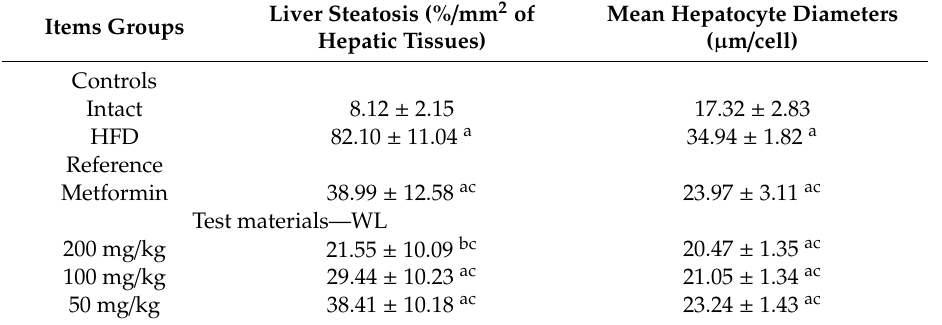
Table 12. Changes in histopathology-histomorphometry of the liver in NFD or HFD supplied mice.